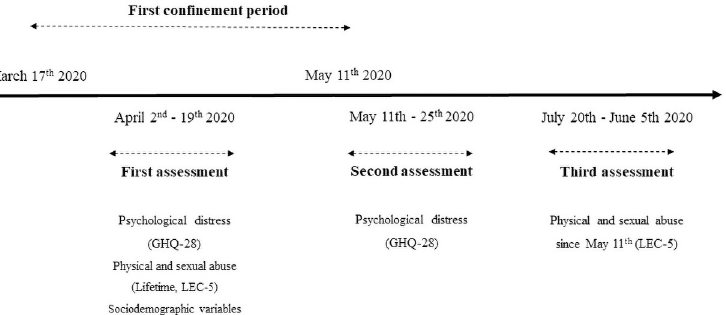
Fig 1. Prospective study design. Data were collected at three time points: during (2–19 April) the first lockdown and at the end (11–25 May), and post lockdown (20 June– 05 July). Note: GHQ-28: General Health Questionnaire 28 items; LEC-5: Life events checklist for